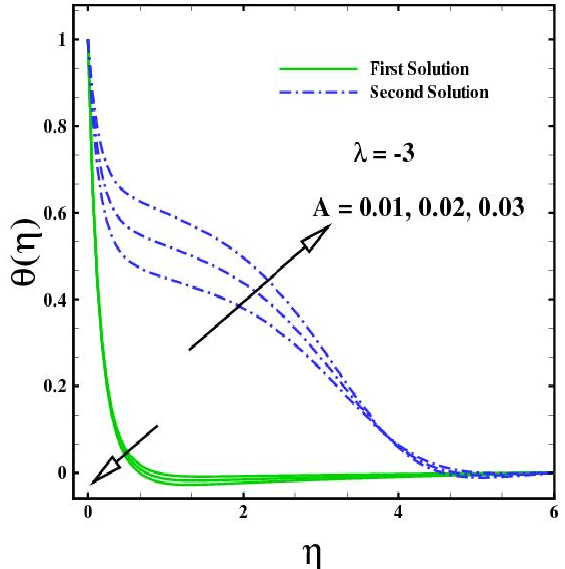
Figure 10. Effect of temperature with several values of A and We = β = 0.3, M = 0.1, S = 4, Ec = B = 0.01, and Pr = n = 2.